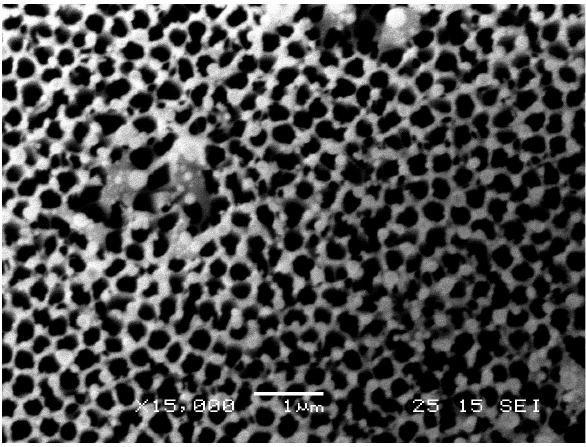
Figure 5. SEM image of the mask after laser